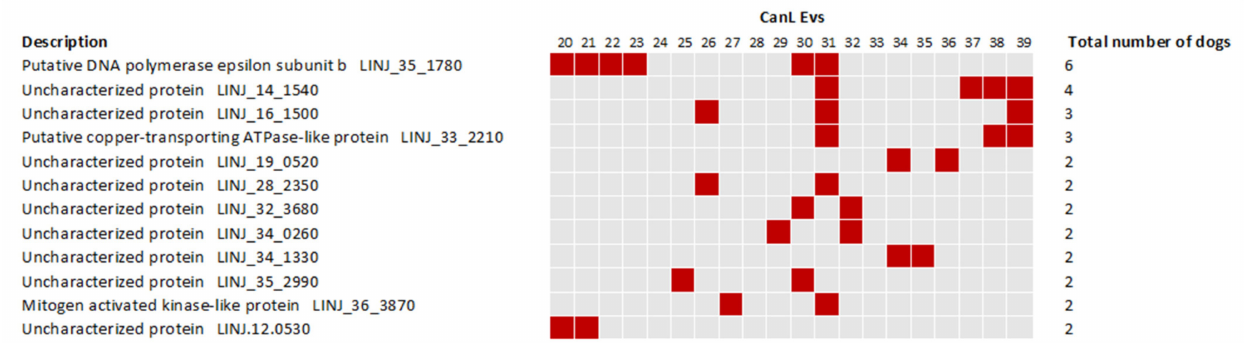
Figure 8. Leishmania infantum proteins identified in CanL individual samples. The presence of a red colour associated to individual proteins represents the detection of that protein in the sample with 1 unique peptide.